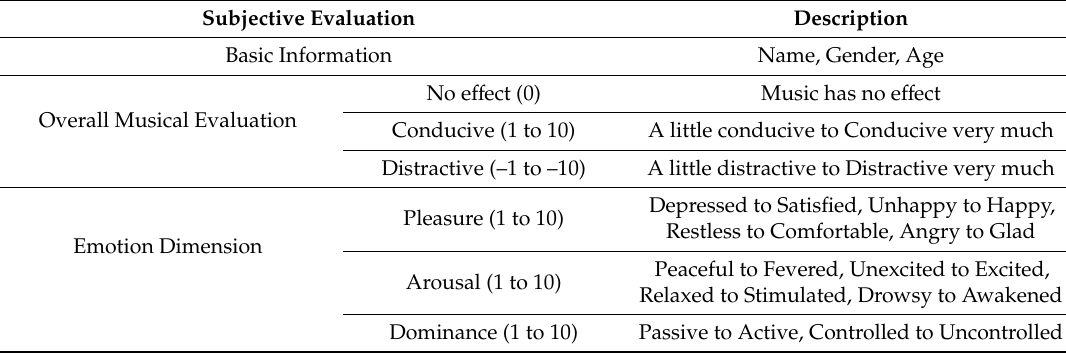
Table 2. Subjective evaluation descriptions during